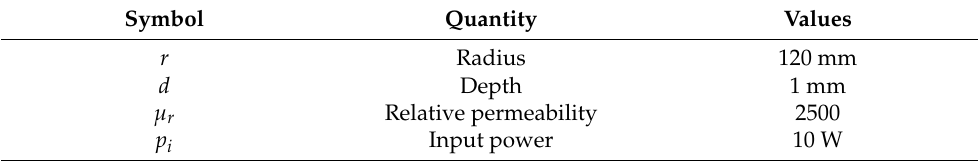
Table 1. Initial parameters of the secondary shield.